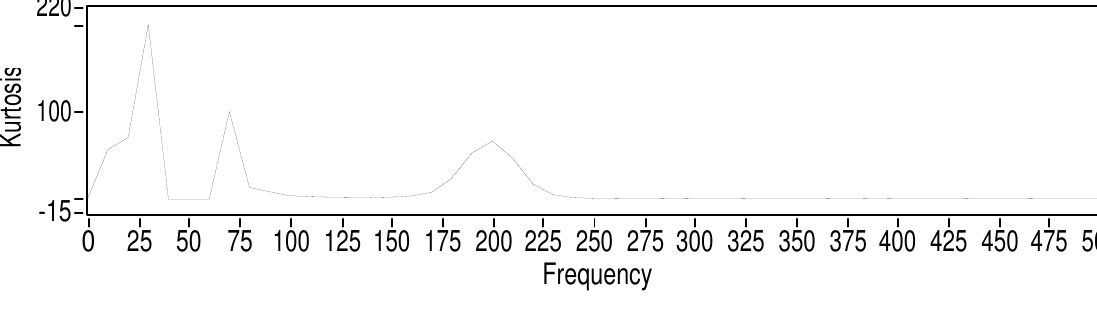
Figure 5. SK analysis over a sag with a coupled oscillatory transient. SK results shown from 0 to 500 Hz of a sag with an coupled oscillatory transient, with Gaussian additive noise with σ = 0 . 05